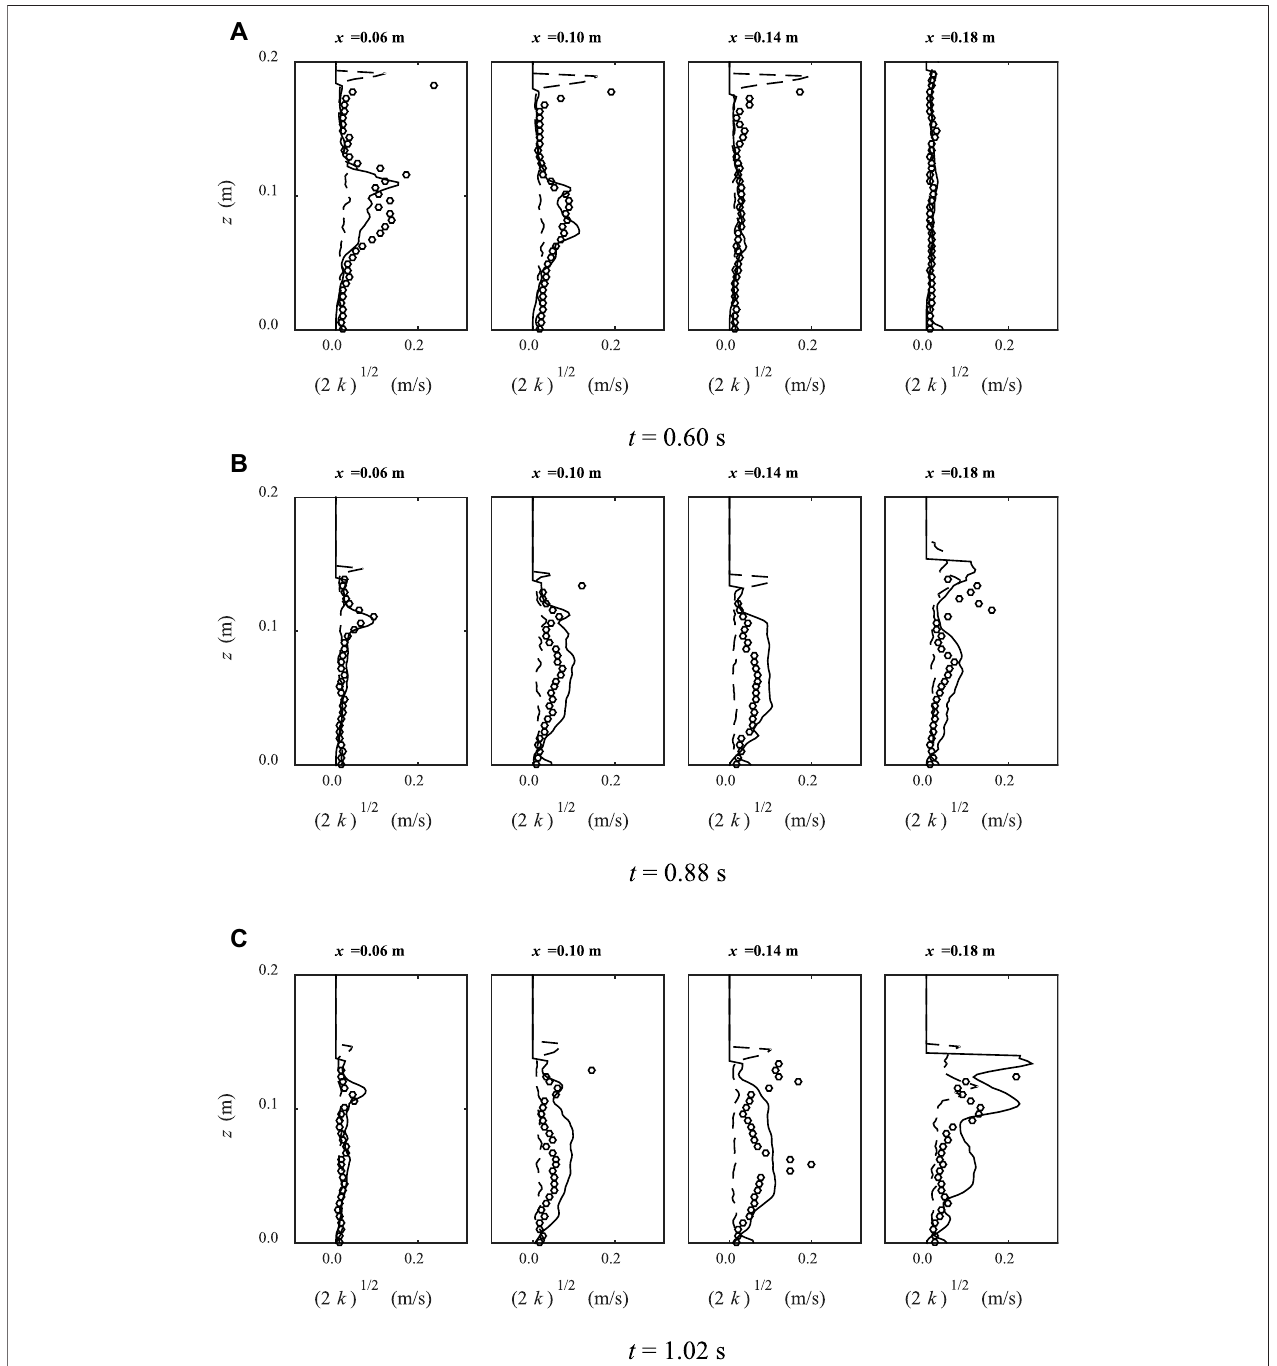
FIGURE 7 | Comparisons between experimental data (circles) and numerical results for the turbulence intensity (m/s) pro fi les, calculated by k - ε model (solid lines) and SPS model (dashed lines) at three times t (cid:2) (A) 0.60 s; (B) 0.88 s; and (C) 1.02 s.